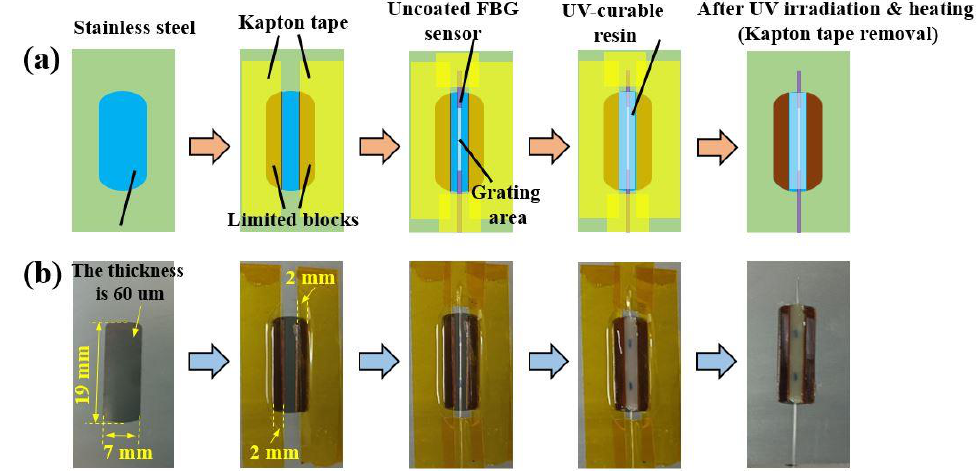
Figure 2. Schematic diagram of the experimental setup for fabricating the uncoated FBG sensors using UV laser based phase mask technology.